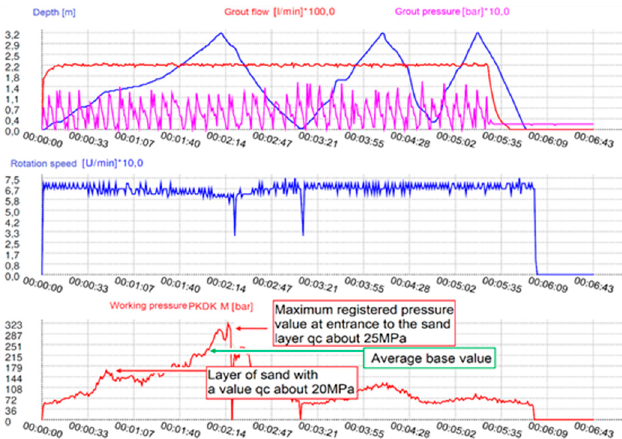
Figure 10. Parameters registered by the device during the formation of the 456 representative columns.